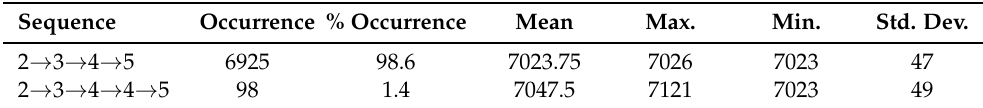
Figure 5. Performance view of mean time duration between activities. Table 11. Two variants of